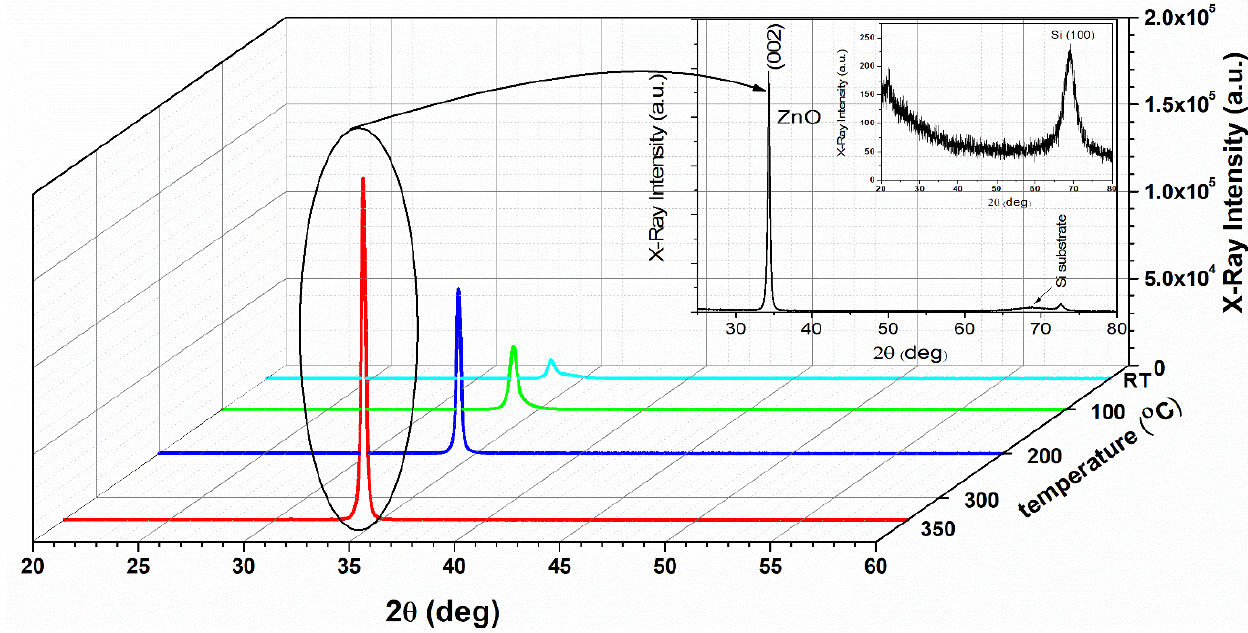
Figure 2. XRD pattern for ZnO thin films and Si substrate (inset).